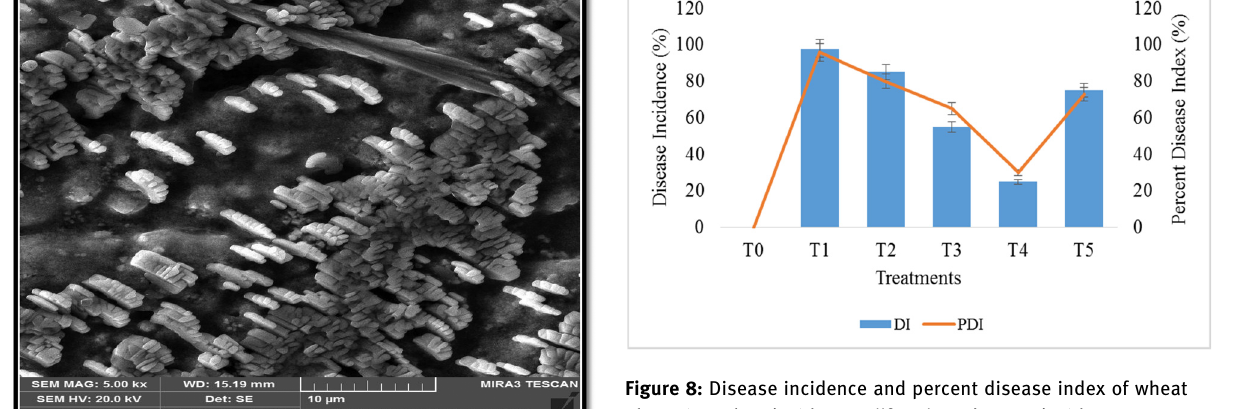
Figure 8: Disease incidence and percent disease index of wheat plants inoculated with P. striiformis and treated with green -